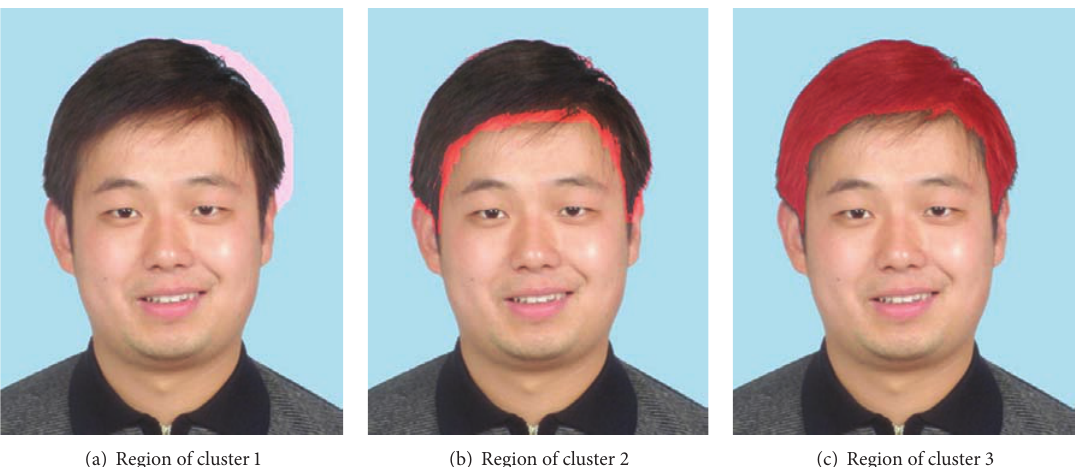
Figure 5: Three regions corresponding to three cluster centers generated by K-means algorithm. They are labeled in light red.